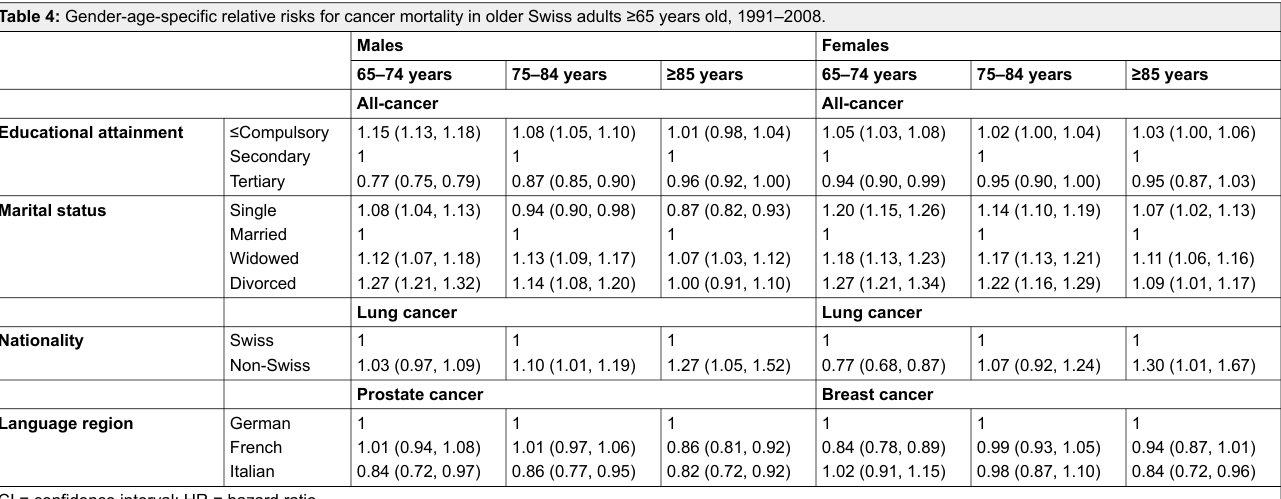
Table 4: Gender-age-specific relative risks for cancer mortality in older Swiss adults ≥65 years old, 1991–2008.